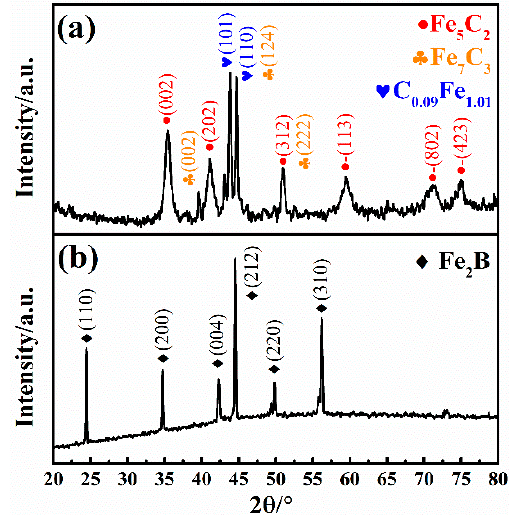
Figure 3. XRD patterns of the borocarburized layer ( a ) after the carburizing process, ( b ) after the boriding process.